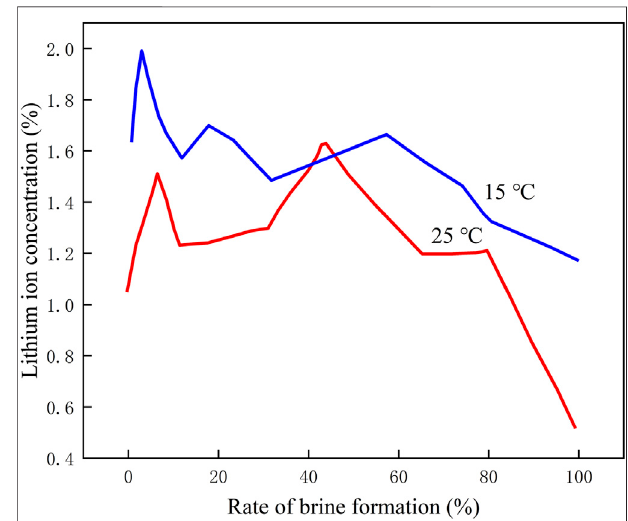
FIGURE 12 | Precipitation of lithium minerals during isothermal evaporation at 15 and 25 ° C. FIGURE 13 | Enrichment of Lithium in brine during isothermal